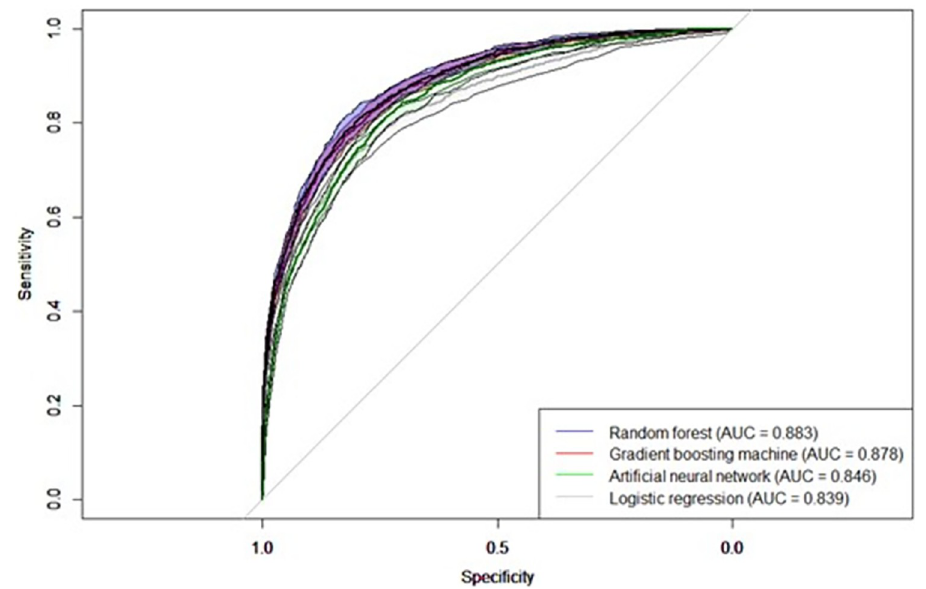
Fig 1. Receiver operating curves of models’ performance on test data, including confidence intervals for 95% confidence level. Confidence intervals were calculated using the cvAUC package in R.